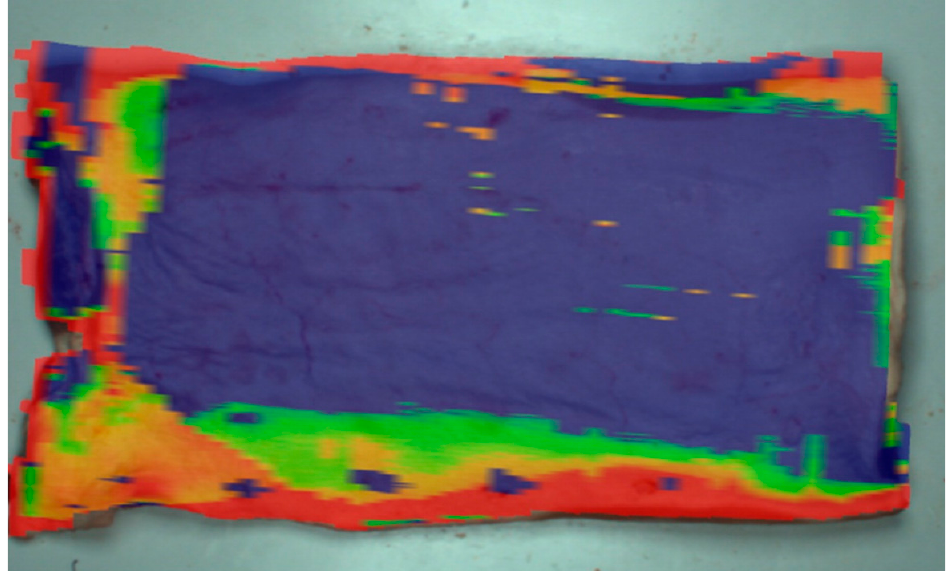
Figure 6. Augmented information includes visualized instructions on how to cut the belly ( A ) and color-coded fat layer thicknesses ( B ). Reproduced from Christensen and Engell-Nørregård [49]. In ( B ), blue indicates the thickness of fat below 7 mm, green to orange indicate thickness between 7 mm and 15 mm and red indicates thickness above 15 mm.